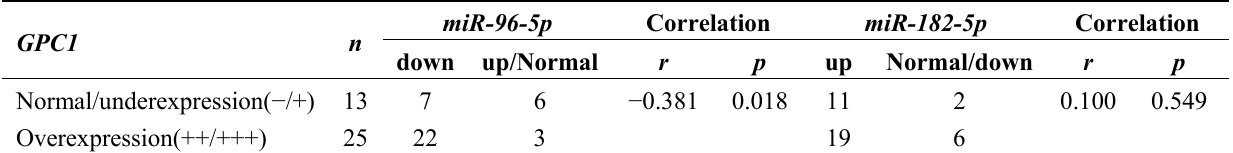
Table 2. Correlations between miR-96-5p , miR-182-5p , and GPC1 protein of PC patients.